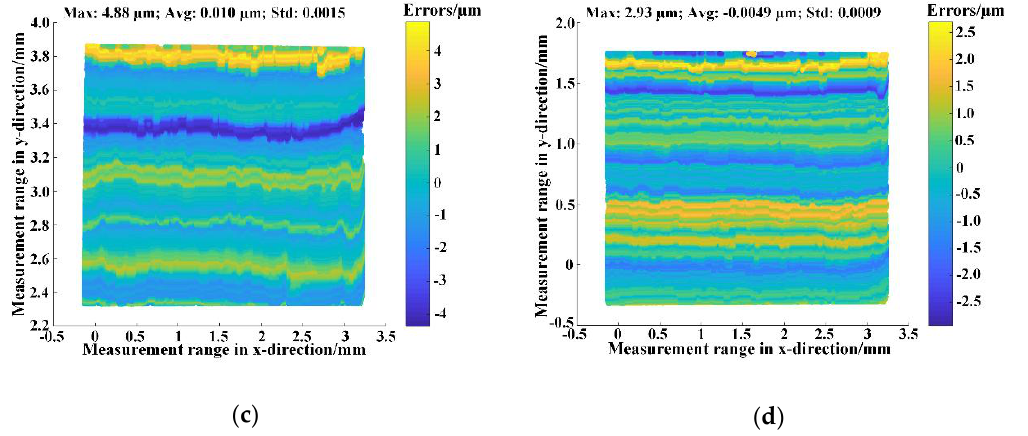
Figure 5. The error distribution of every level of the measured point cloud. Here ‘Max’, ‘Avg’, ‘Std’ denoted the maximum absolute error, average error and standard deviation, respectively. ( a ) and ( b ) showed the error distributions of high- and low-level point cloud data of the 300 µm step master, respectively, and ( c ) and ( d ) showed those of the 100 µm step master.